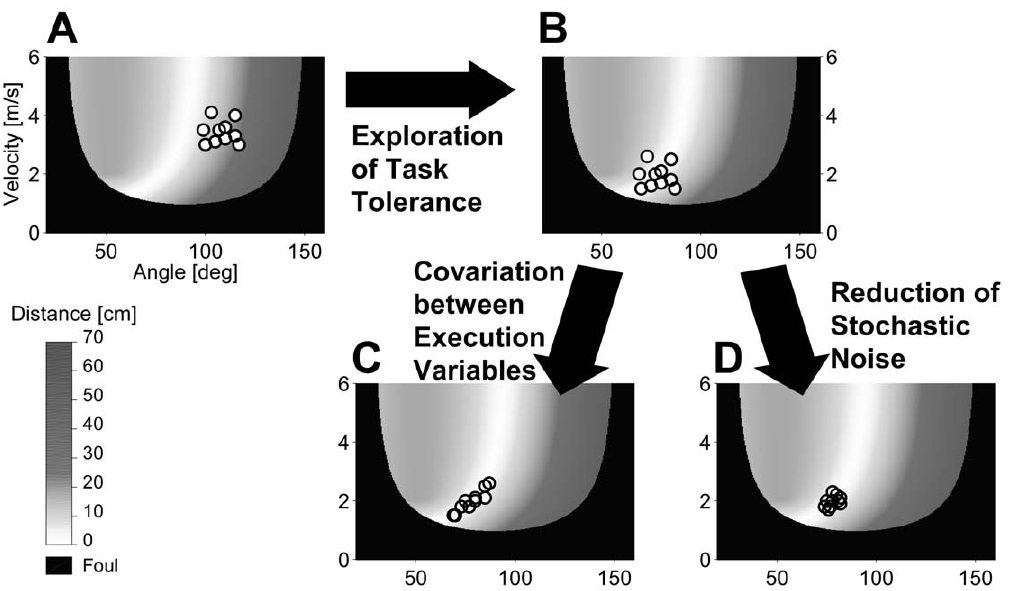
Figure 2. TNC components. Schematic Illustration of the three components contributing to performance change. A: A random set of 10 throws is plotted onto the execution and result space. The mean result of these trials, as indicated by the color coding, can be improved by shifting the cloud of trials to a more error tolerant area. That is, the mean performance of these 10 trials (with identical dispersion) would be better if execution variables were on average 80 u and 1.9 m/s ( B ). This improvement can be achieved through exploration of the task space, searching for error (noise) tolerant areas. Hence, we call this component Tolerance . C and D show two additional options for performance improvement. Having found a tolerant solution (as in B ), performance can be improved even further by co-varying the execution variables such that the trials align with the solution manifold ( C ). Note that the co-variated set of trials still has the same dispersion as the sets in A and B . Finally, reducing dispersion, or rather stochastic noise, can improve performance as well ( D